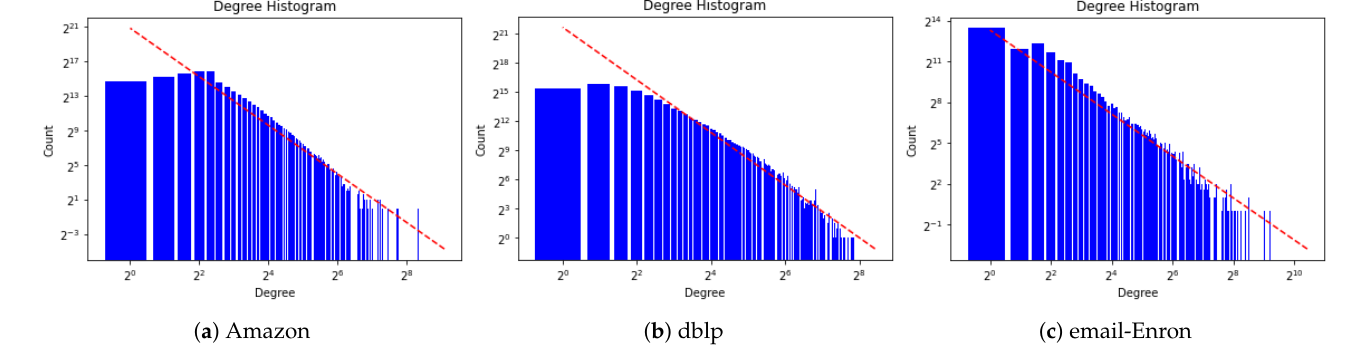
Figure 6. Power law distribution